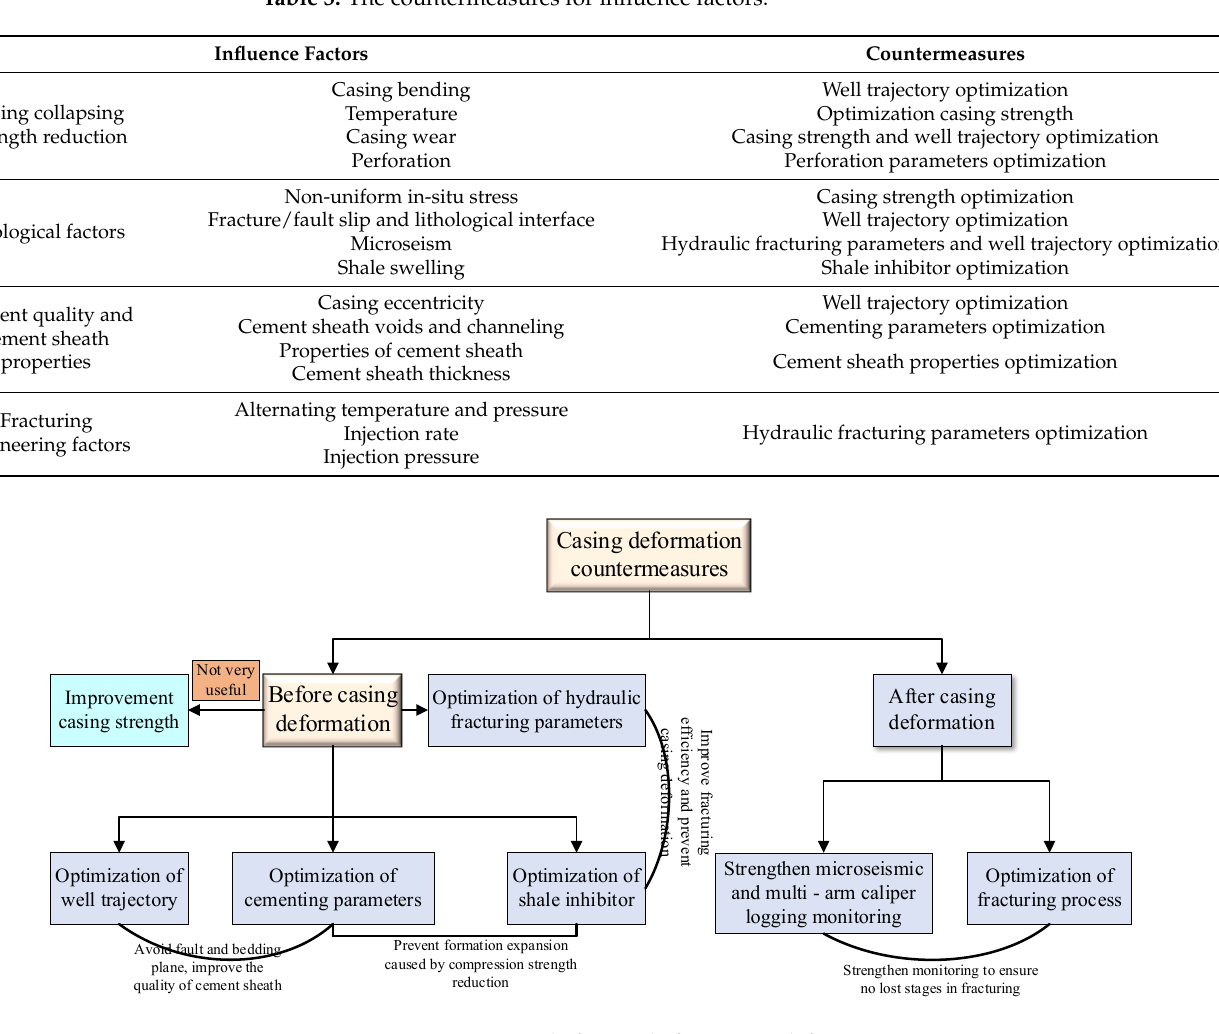
Table 3. The countermeasures for influence factors.